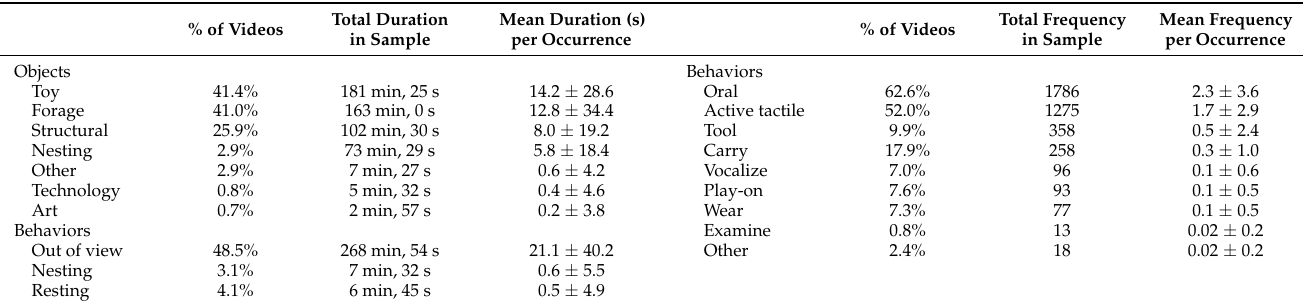
Table 5. Percentage (%) of sampled videos in which the ethogram category was present and total and mean ( ± SD) durations and frequencies for object use and manipulation behaviors ( n = 765 occurrences; 615 videos; 732 min, 58 s of